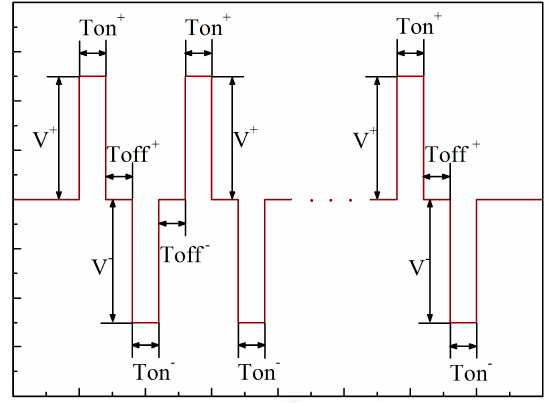
Figure 1. Schematic of the pulse output with a bipolar constant current power supply. Table 1. Microarc oxidation process parameters for coatings formed on aluminum alloys at different anode pulse-widths.